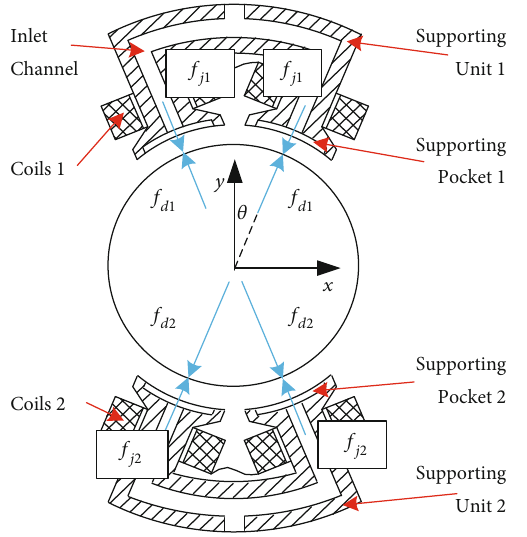
Figure 5: Force diagram of single DOF supporting system.